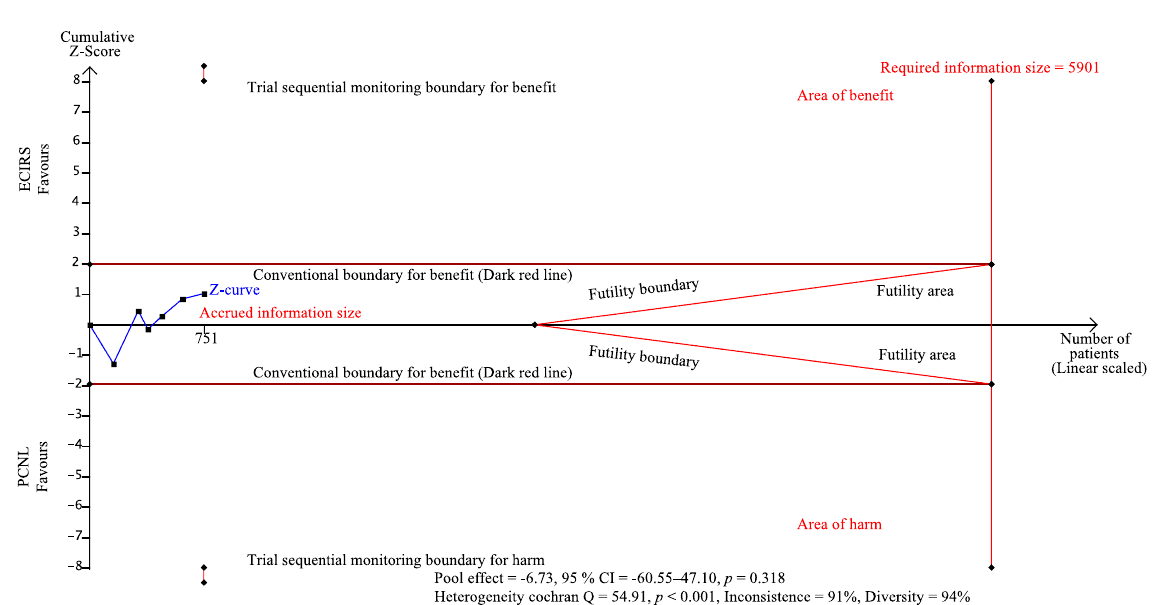
Figure A54. Comparison-adjusted funnel plot in outcome for hospital stay. Appendix K. Table A8. Summary of the Result of Meta-Regression Analysis Regarding Outcome Measurements and Publication Date Outcomes